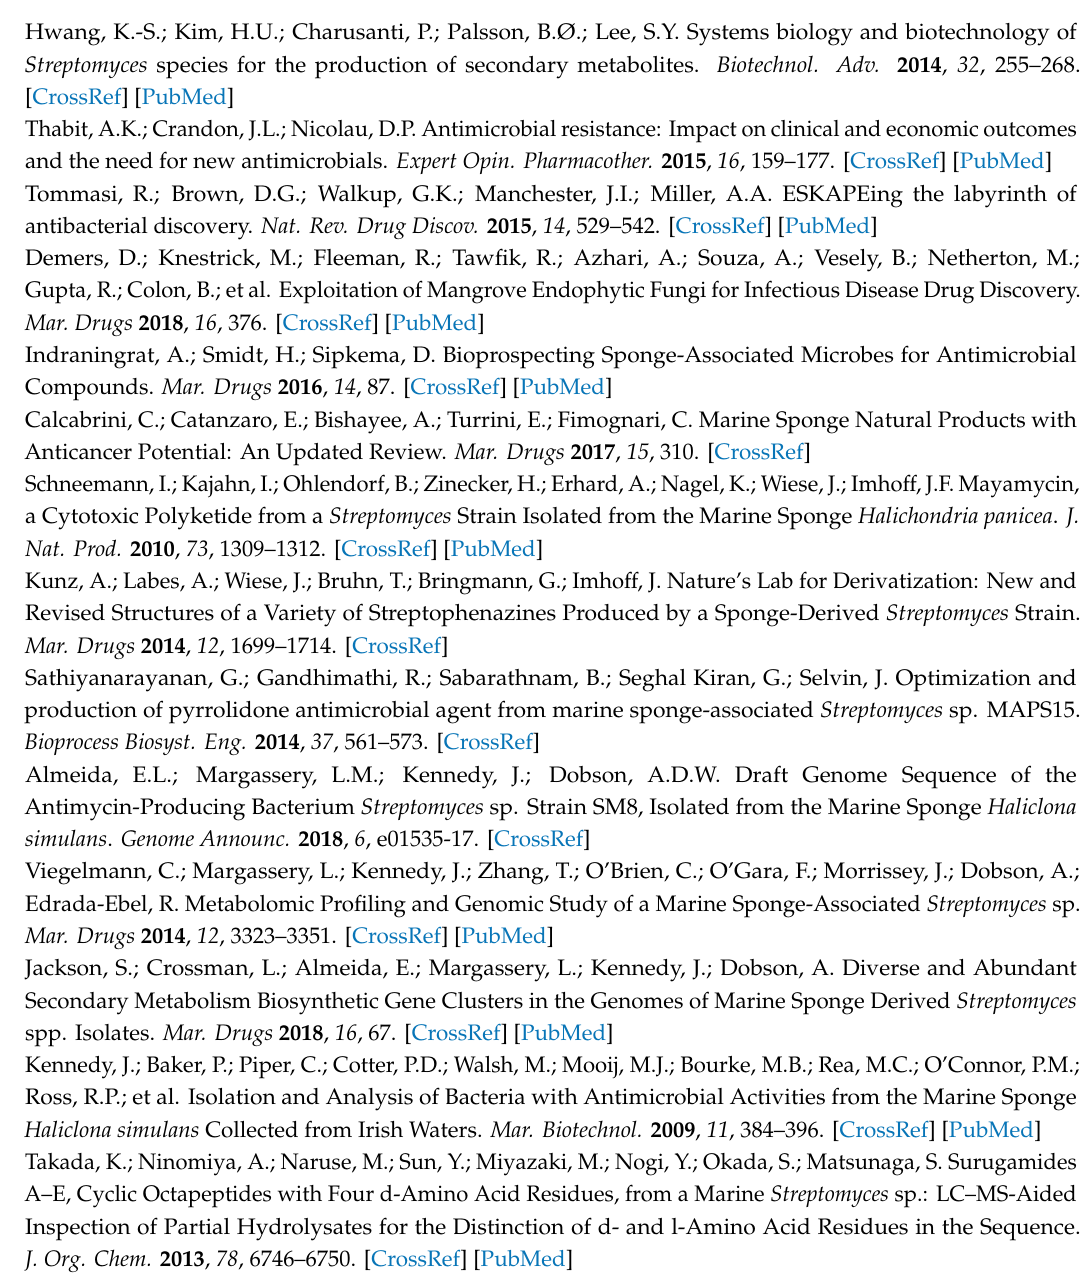
Figure S1: Groups of orthologous genes in the genomes of the albidoflavus phylogroup, Figure S2: Calibration curve for surugamide A, Table S1: Genome statistics of the albidoflavus